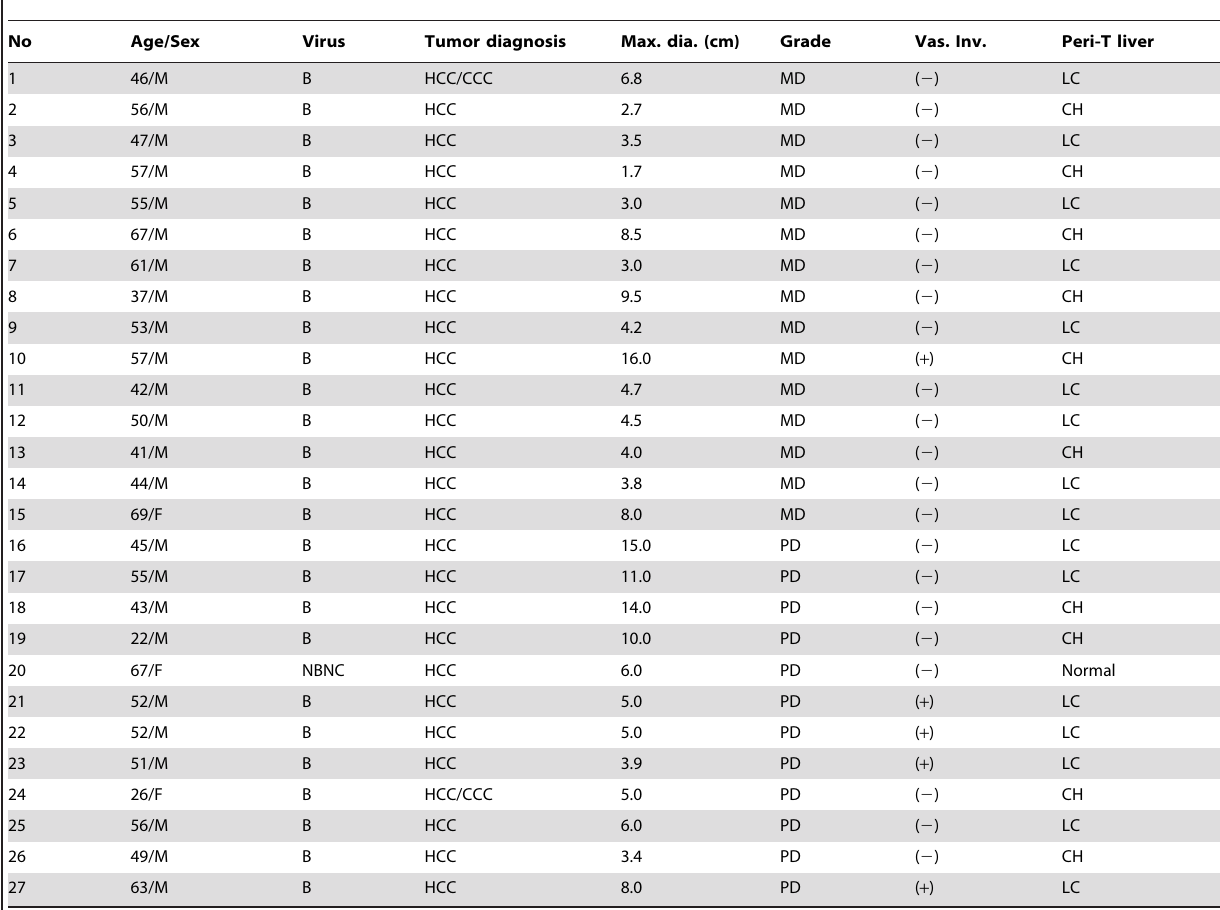
Table 1. Patient and tumor characteristics in South Korean